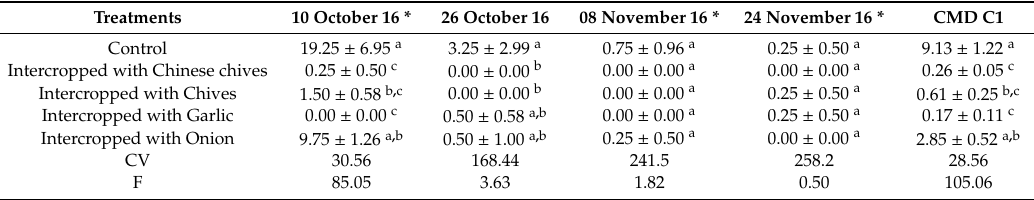
Table 3. Mean number ( ± Standard deviation) of Tetranychus urticae mobile forms and cumulated mite days (CMD) per cm 2 , on strawberry leaves, submitted to Amaryllidaceae plants intercropping, in the first cycle. Londrina, Paran á , Brazil, October–November 2016.